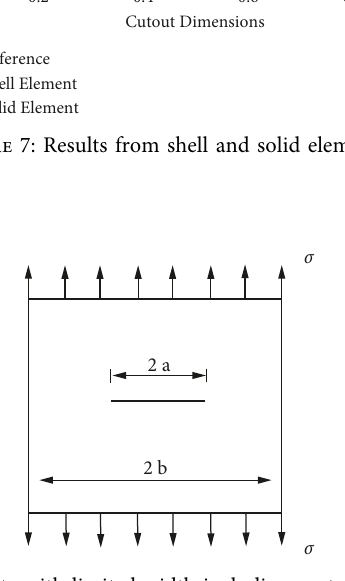
Figure 8: Plate with limited width including central crack [23].